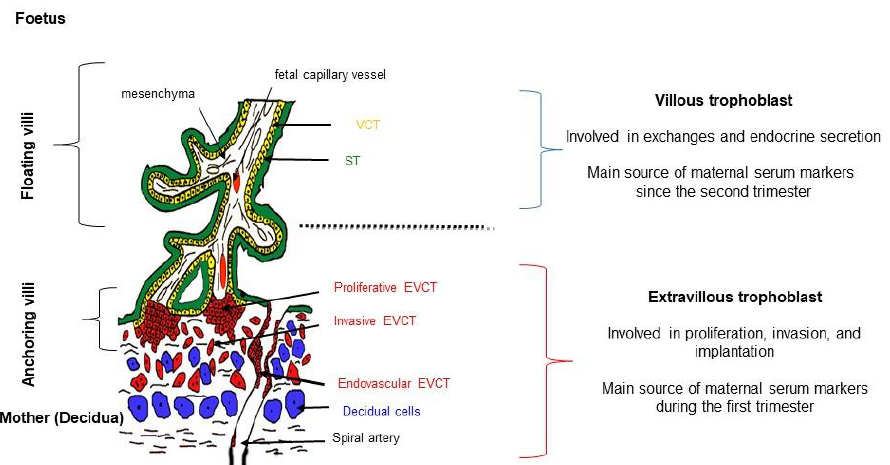
Figure 2. Human placental definitive villi and trophoblastic tissue. From the end of the first trimester of gestation, the human placenta is composed of two types of villi: the anchoring villi with extravillous cytotrophoblasts (EVCT) that proliferate, migrate, and invade the maternal uterine wall to reach the spiral artery; the floating villi composed of villous cytotrophoblasts (VCT), aggregating and fusing to form the syncytiotrophoblast (ST) on the borders of floating villi in contact with maternal blood as from 10 to 12 WG. EVCT is likely to be the major source of maternal serum markers in early pregnancy, whereas ST becomes the major source at the end of the first trimester of gestation.